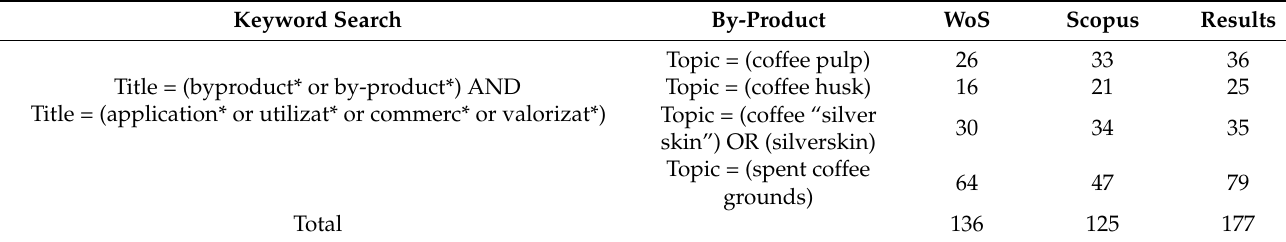
Table 1. Keyword search